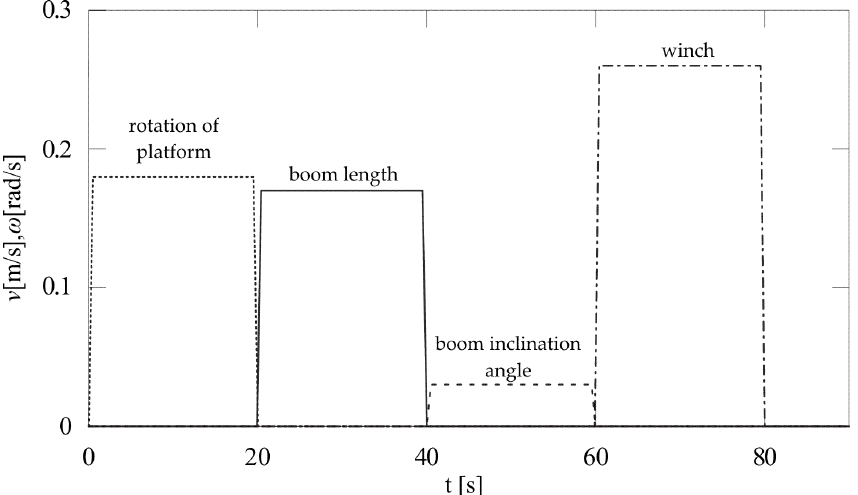
Figure 18. Control functions (crane actions).